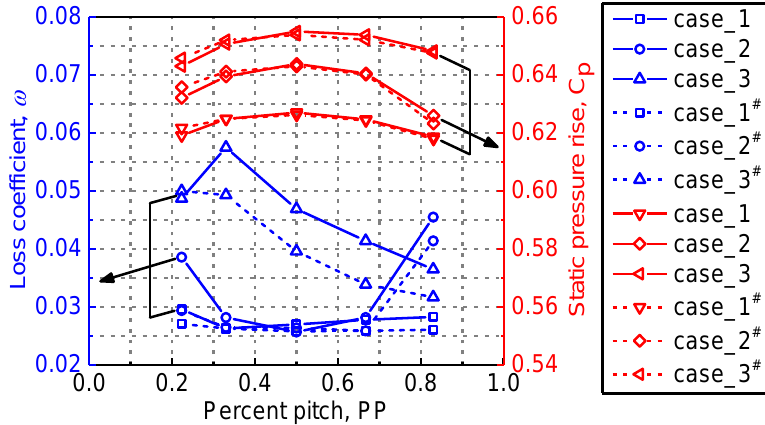
Figure 6. Total pressure loss and static pressure rise of three cases with “#” denoting “impact-free entry” designs, without “#” denoting original